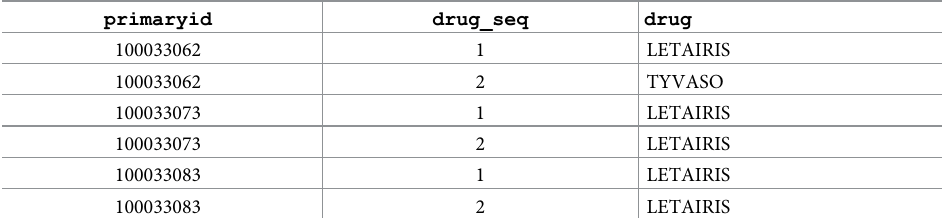
Table 4. Example of a dataset of three patients for the drugds data.